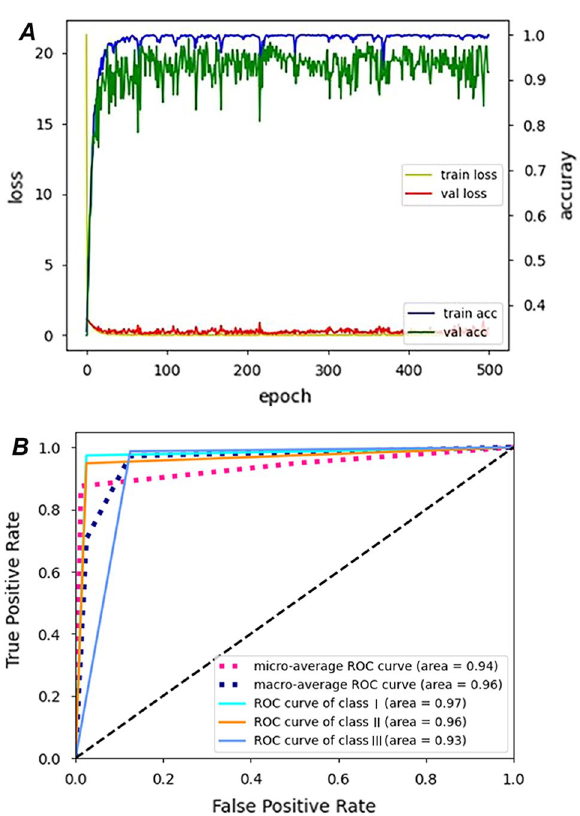
Figure 3. Performances of deep convolutional neural network-based AI model. A. Accuracy and loss of training and validation according to the number of epochs. B. Receiver operating characteristic (ROC) curve and the area under the curve (shown in